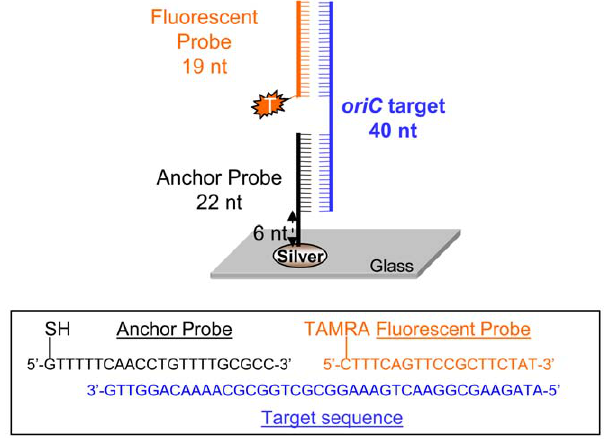
Figure 2. Schematic representation of anchor and fluorescent probes binding to SalmonellaoriC target DNA.